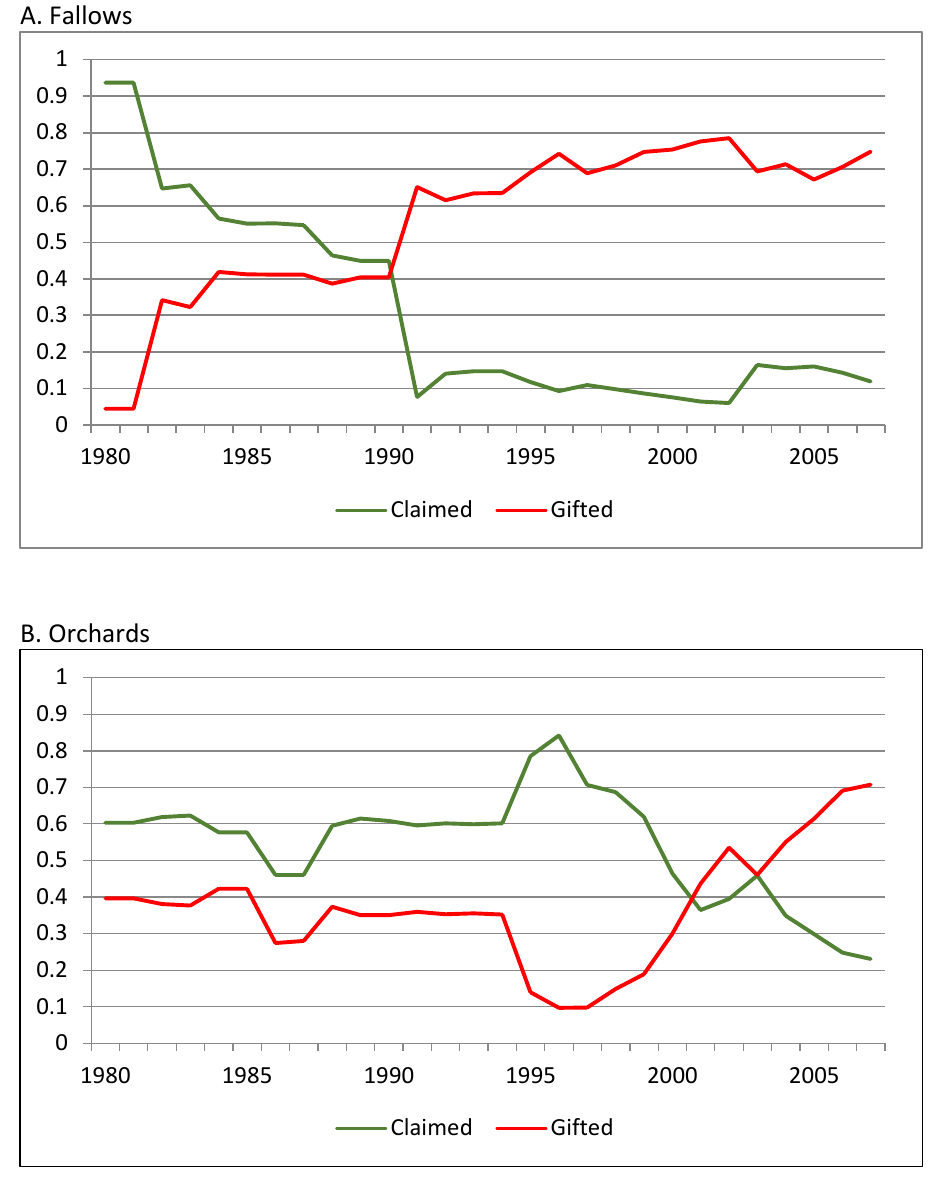
Figure A1.2. Gini decomposition by mode of acquisition of upland fallows and orchards,